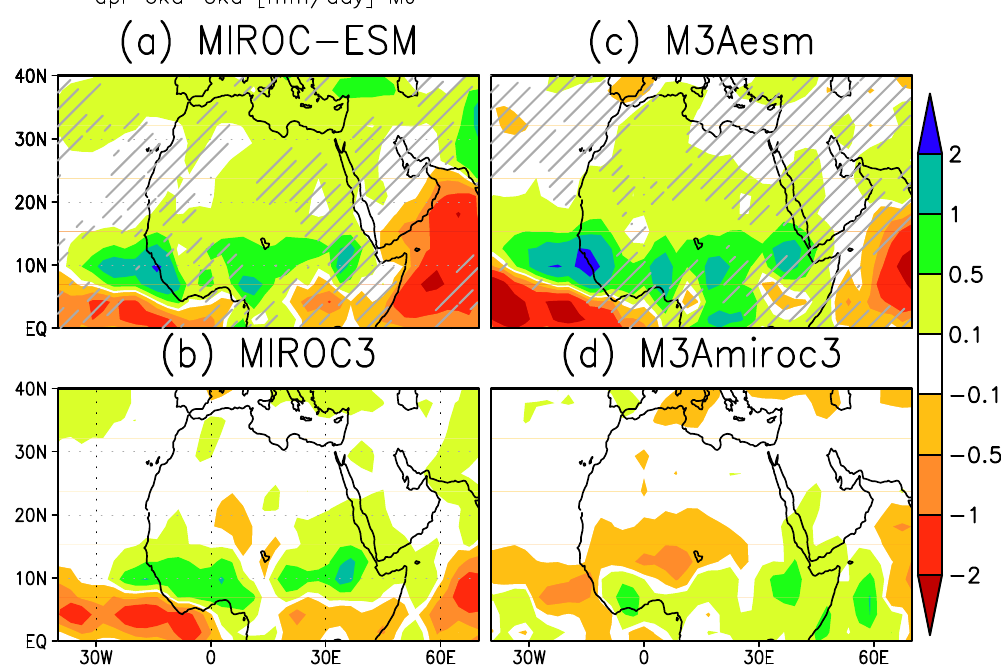
Fig. 16. 6–0ka precipitation change over the African area in MJ (mmday − 1 ) for (a) MIROC-ESM, (b) MIROC3, (c) M3Aesm, and (d) M3Amiroc3. Hatched areas in the upper figures indicate regions where the precipitation changes in the upper and lower panels are insignificant in a t test